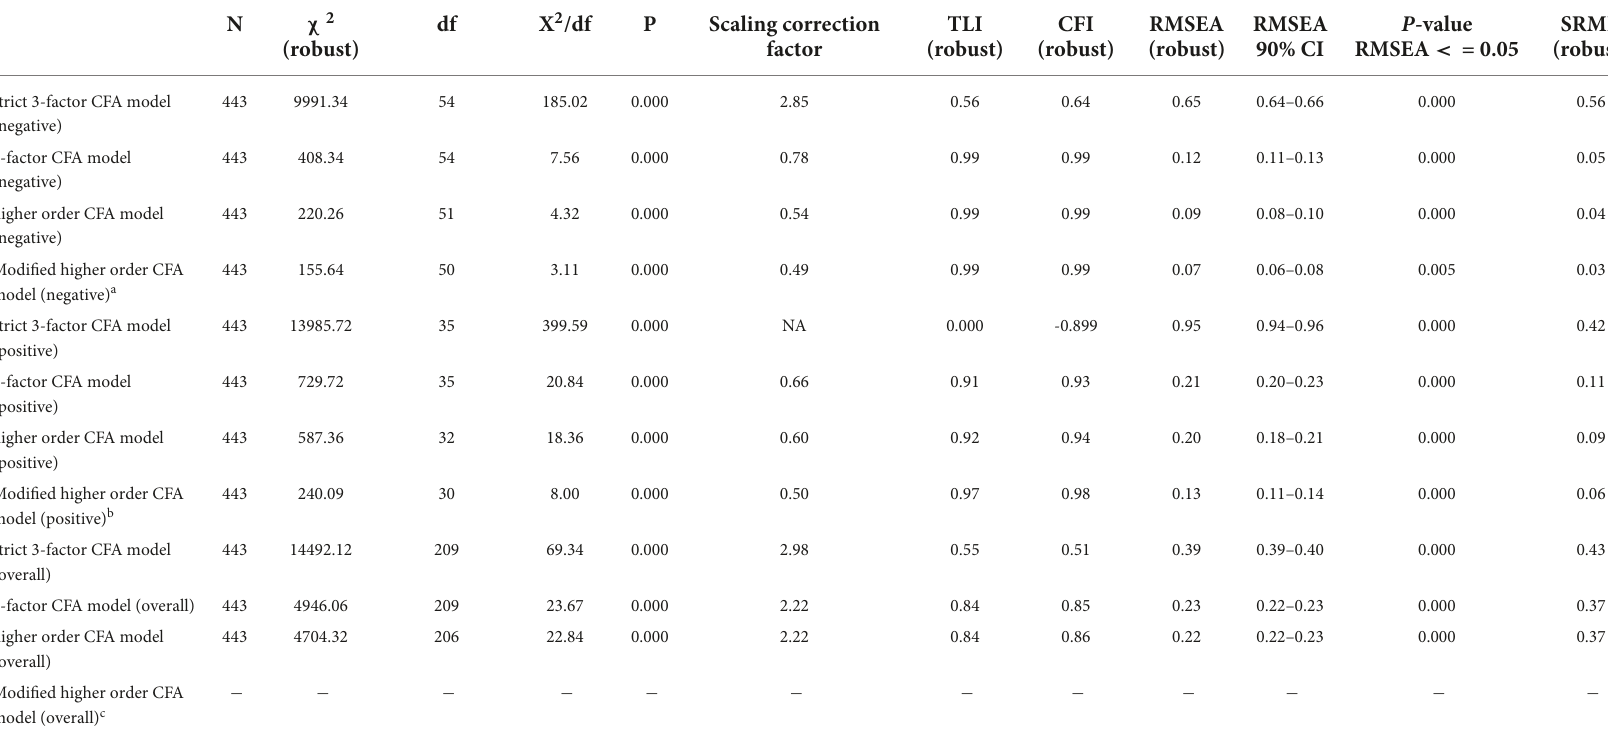
TABLE 3 Global Fit Indices of Confirmatory Factor Analysis: German version of the Psychological Consequences of Screening Questionnaire (PCQ) - weighted least square mean and variance adjusted estimators